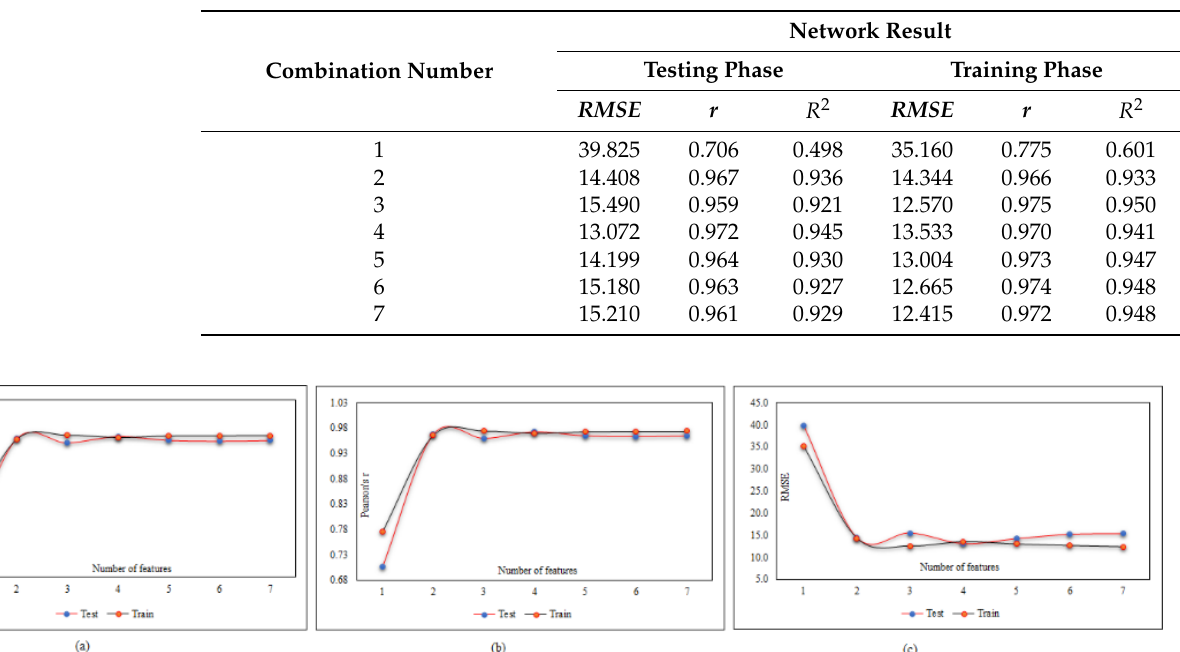
Table 10. The calculated accuracy criteria for the performance of the implemented models for different input numbers.